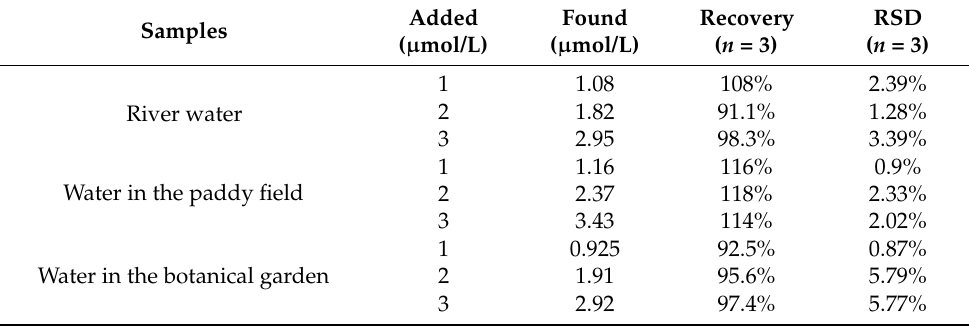
Table 4. Results of recovery of different water